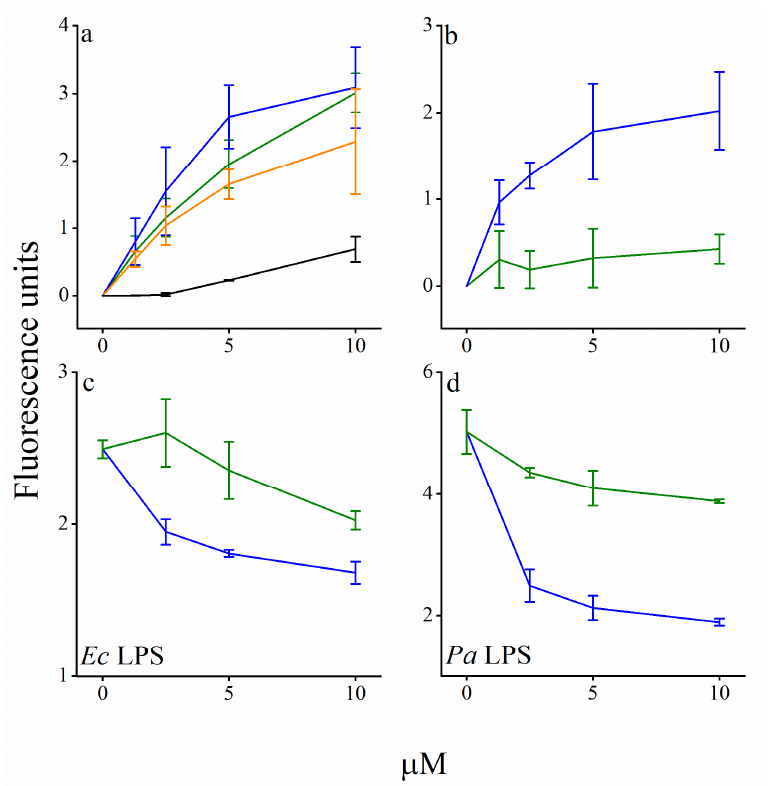
Figure 5. Lipopeptide capacities to affect E. coli outer membrane permeability. ( a ) Outer membrane (OM) permeabilization to the hydrophobic dye NPN was determined 10 min after bacteria ( E. coli 25922, 2 × 10 8 CFU/mL) were exposed to each peptide (5 μ M) in NPN-containing HEPES at 37 °C. p << 0.05 for comparing C 14 OOc 12 O to C 14( ω 5) OOc 10 O or to PMB, and p > 0.05 for comparing C 14( ω 5) OOc 10 O to PMB. Color code (panels ( a – d )): green, C 14( ω 5) OOc 10 O; orange, C 14 OOc 12 O; black, OOc 12 O; blue, polymyxin B (PMB). ( b ) OM permeabilization (as in panel a ) in presence of 10 mM MgCl 2 ; ( c , d ), Dansyl-PMB displacement assay using LPS from Escherichia coli and Pseudomonas aeruginosa , respectively, as measured 1.5 h after incubation in HEPES with C 14( ω 5) OOc 10 O (green) or PMB (blue).